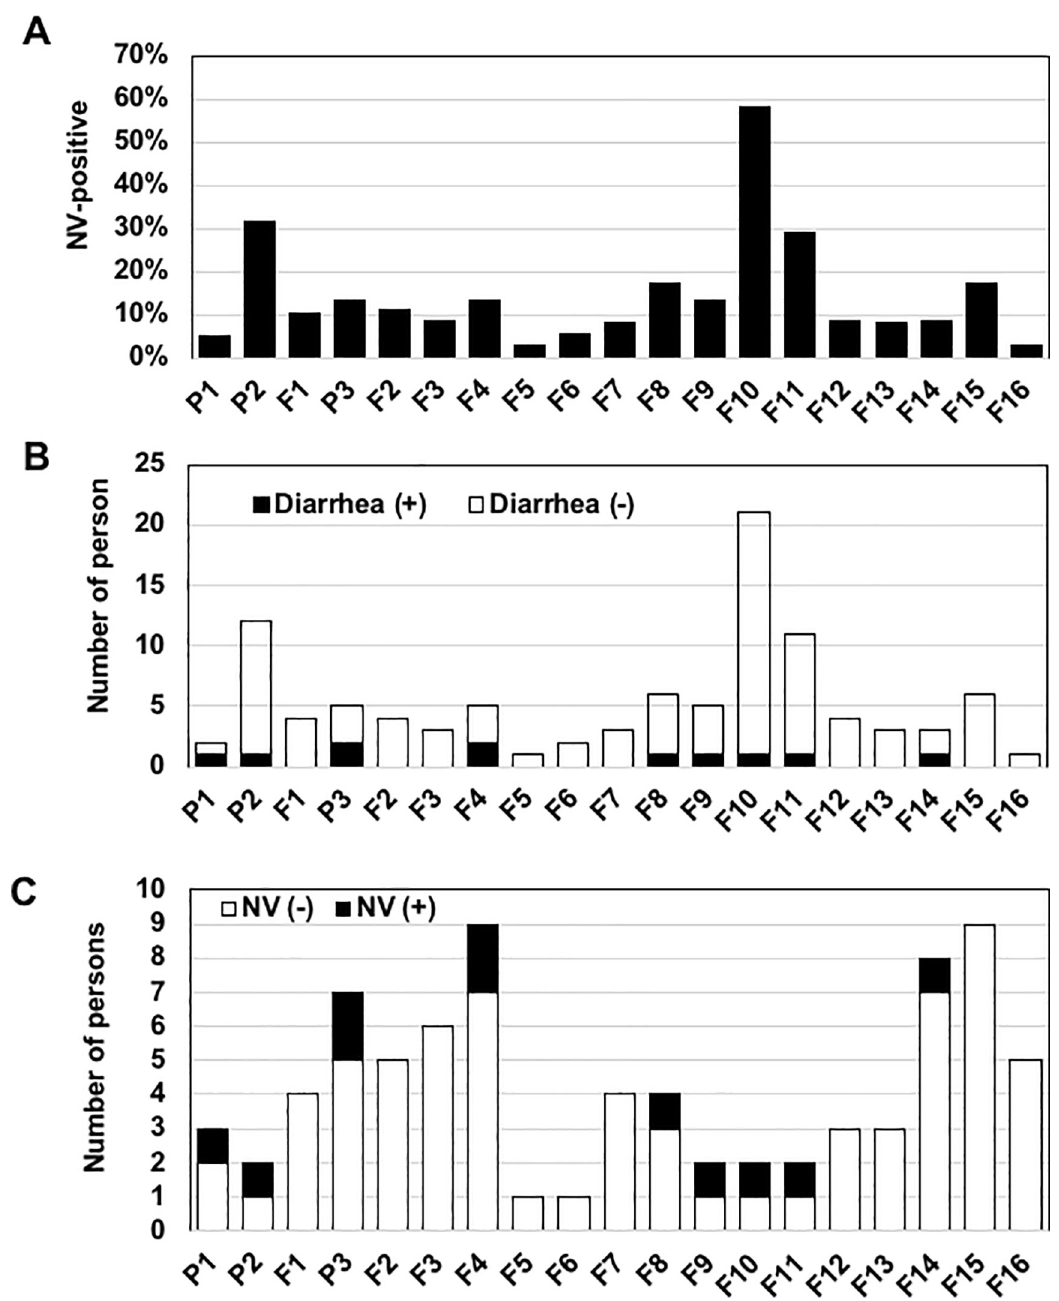
Fig 3. The monthly distribution of NV and individuals with diarrhea. (A) The monthly distribution of NV in the total samples. The NV positivity in samples collected each month is shown. (B) Diarrhea episodes of the NV-positive samples. The numbers of individuals with ( black bars ) or without ( white bars ) a diarrheal episode within 1 month prior to the sample collection are shown. (C) The monthly distribution of the incidence of diarrhea. The numbers of individuals who had an episode of diarrhea within 1 month prior to the sample collection among the NV-negative ( white bars ) and NV-positive individuals ( black bars ) in each month are